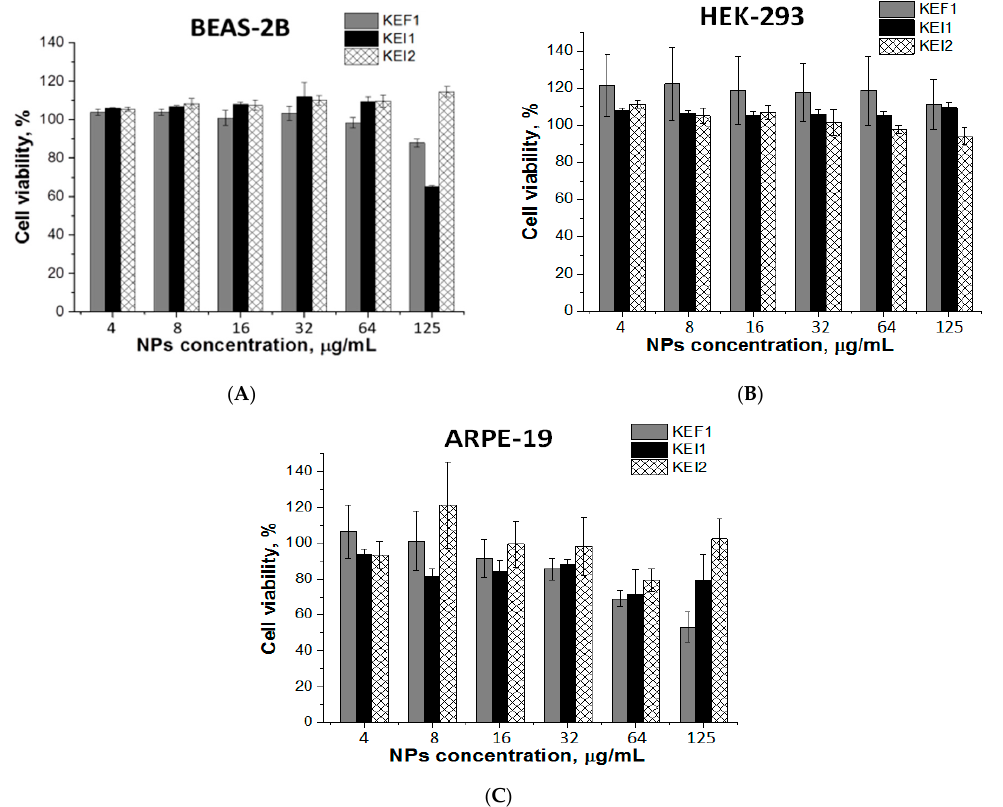
Figure 5. Cytotoxicity of the nanoparticles in BEAS-2B ( A ), HEK-293 ( B ) and ARPE-19 ( C ) cells (72